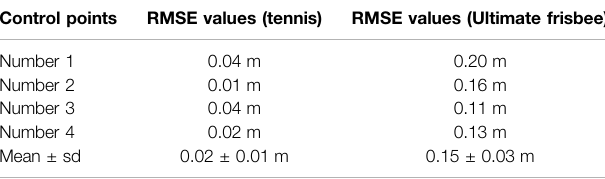
TABLE 2 | RMSE values for the four control points used to evaluate the static accuracy during the calibration procedure on the tennis court and on